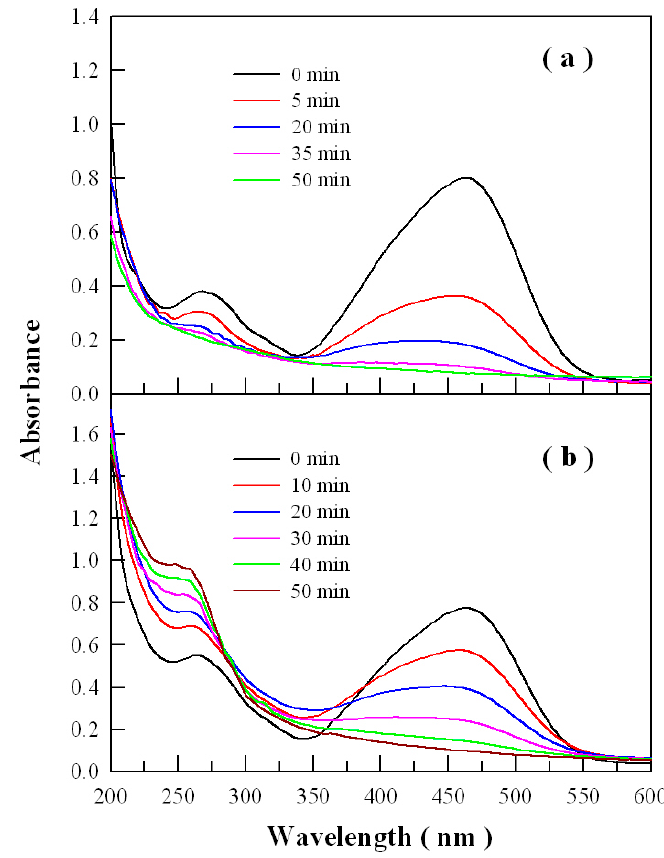
Figure 9 . Absorption spectra of methyl orange solution as a function of UV irradiation time in the presence of ZnWO 4 nanoplates ( a ) and in the presence of ZnWO 4 nanoparticles ( b ).